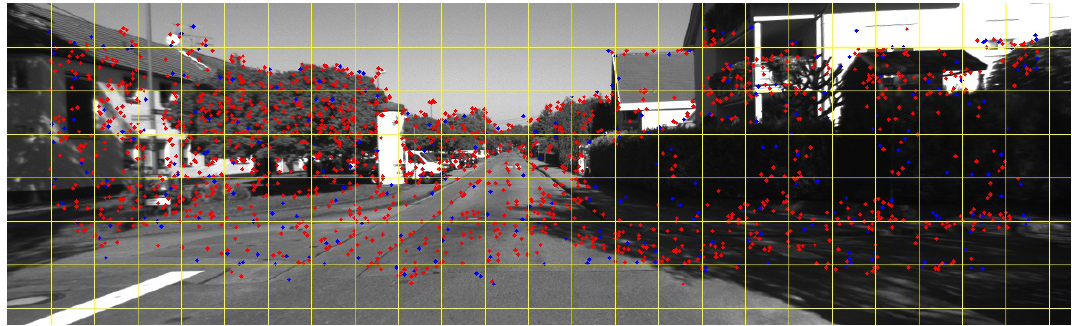
Figure 2. Features before and after bucketing: the red points stand for features before bucketing, the blue points stand for features after bucketing, and the yellow lines depict individual buckets.